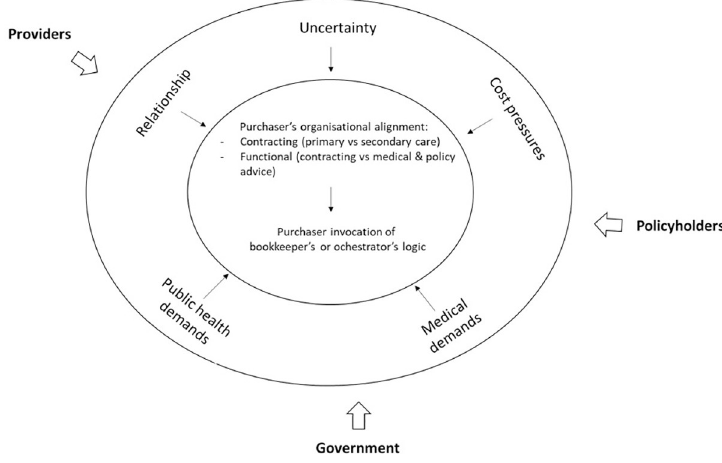
Fig 2. Overview of the different stakeholders, their pressures and the purchaser’s internal